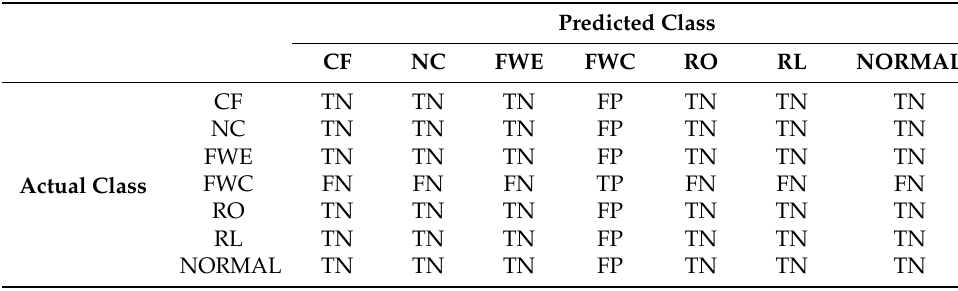
Table 1. Confusion matrix for